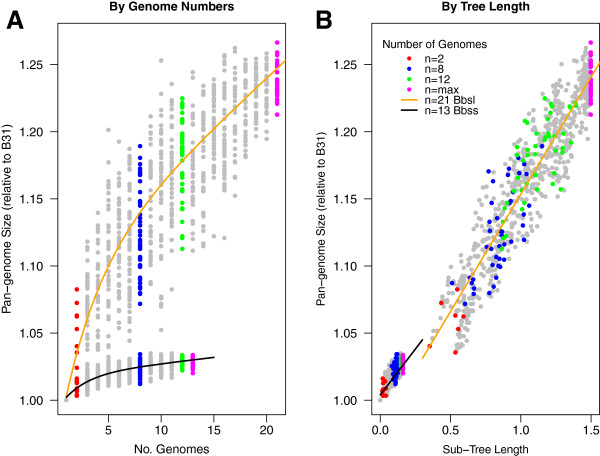
Phylogenetic correlation of B. burgdorferi s.l. and B. burgdorferi s.s pan-genomes. (A) Pan-genome sizes, calculated in permutations where the B31 genome is used as reference, are plotted against the number n of genomes in the comparisons. Data points were fitted with negative exponential growth models (see Methods) [69]. The least-square fitted model for B. burgdorferi s.l. (solid orange line) takes the following parameter values (and respective standard errors): D=0.995 (0.0121), tg(θ)=0.00725 (0.00083),κ=0.0445 (0.0187), and τn=3.47 (1.06). The model fit has an R2=0.7479. The model for B. burgdorferi s.s. (solid black line) has the following parameter values (and respective standard errors): D=1.001 (0.00276), tg(θ)=0.000917 (0.00027),κ=0.01446 (0.0088), and τn=2.287 (0.857). The model fit has an R2=0.6065. (B) The same pan-genome calculations were fitted linearly with the sub-tree length of genomes in comparison, according to the neutral coalescence model: Ωn=Ω0+ωTn, where ω is the rate of gene acquisition [77]. The linear model for B. burgdorferi s.l. has Ω0=1458 (3.8) and ω=260.3 (3.5) with a greatly improved R2=0.8762 (p<2e-16). The linear model for B. burgdorferi s.s. has Ω0=1501 (0.91) and ω=202.3 (0.05) with a slightly improved R2=0.6126 (p<2e-16). The improvement is due to a tighter fit of predicted pan-genome sizes with the tree lengths, in which some groups of genomes are more phylogenetically diverse (thus having larger pan-genome sizes) than others albeit the total number of genomes in comparison remain the same (e.g. comparing n=8, in blue, in the two panels).